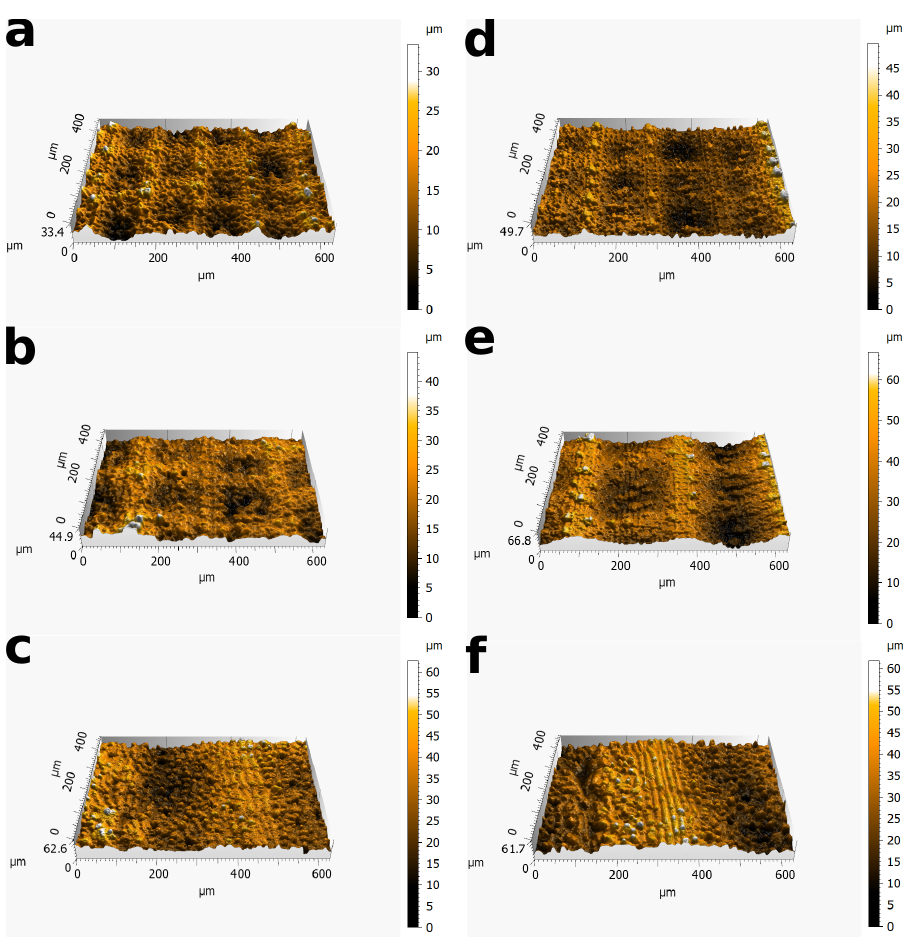
Figure 6. Interferometric images of texture: ( a – c ) Phyllostachys, Sasa, and Ginkgo, respectively; ( d – f ) replicas of Phyllostachys, Sasa, and Ginkgo,